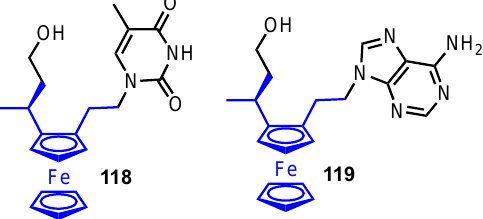
Figure 10. Ferronucleosides developed by Tucker.